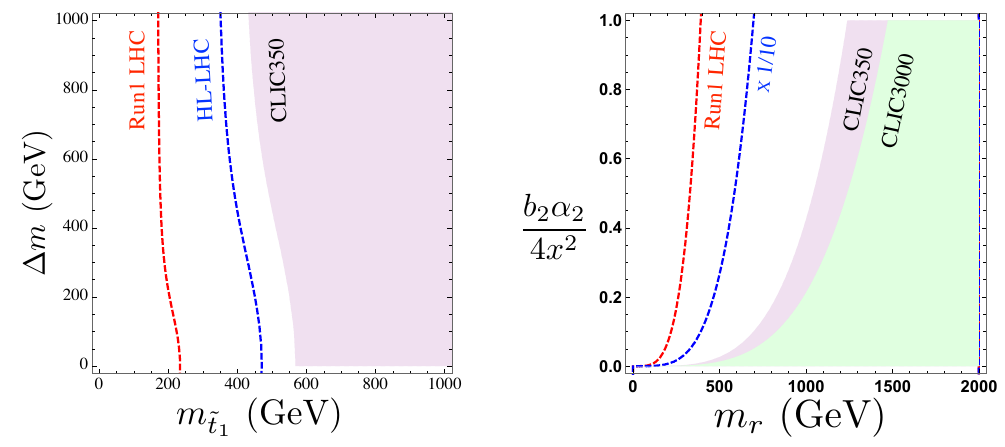
Figure 6 . Mass reach for scenarios with new scalars. Boundaries correspond to 95% CL exclusions. (Left panel) Current and expected mass reach for interpretations of (cid:22) c g as limits on stop masses. (Right panel) Limits on the EFT coe(cid:14)cients interpreted in terms of the mass and coupling of the dilaton (cid:12)eld, where the (cid:12) -function coe(cid:14)cient b 2 and the parameter x = f=m r are introduced in the